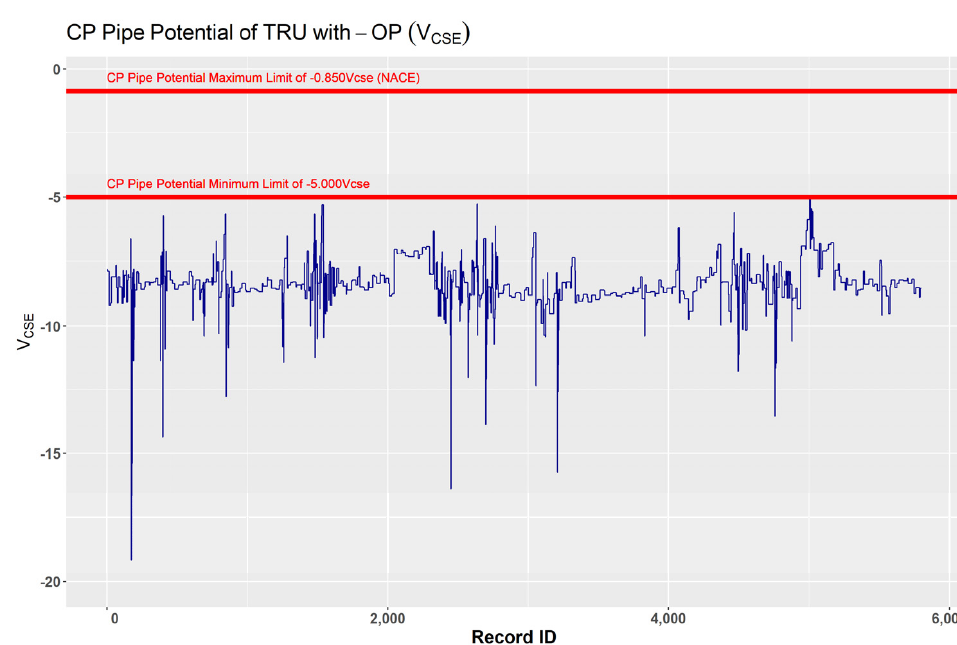
Figure 6. CP pipe potential below operating window.